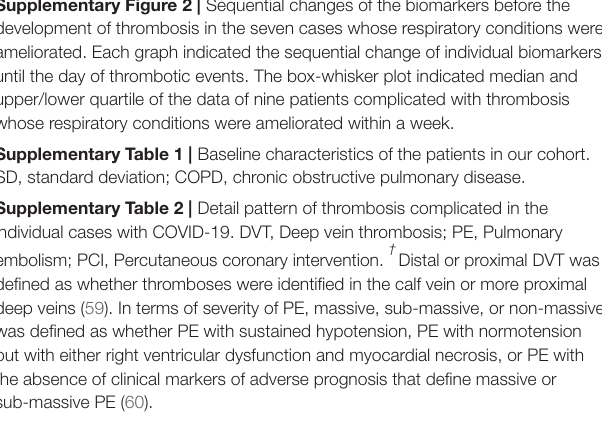
Supplementary Figure 1 | Floating thrombus in aortic arch. Single-phase contrast-enhanced CT shows a filling defect in the aortic arch (arrowhead).